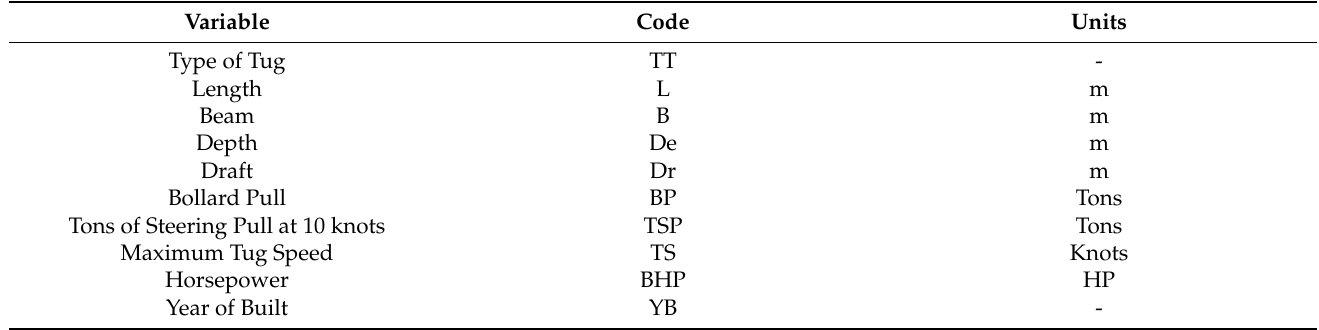
Table 1. Identification of tugs’ variables and used